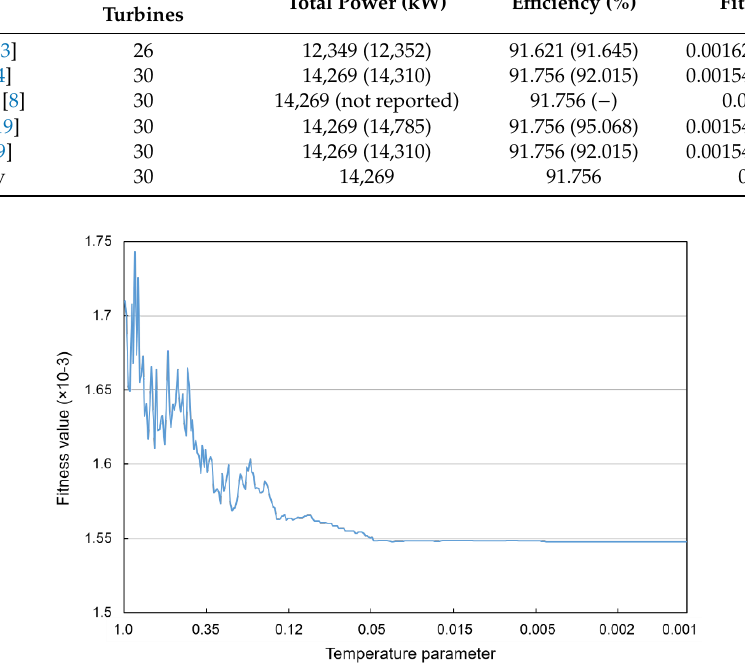
Figure 6. Fitness variation during the process in case study (a). Table 3. Layout Results for Case Study (a).